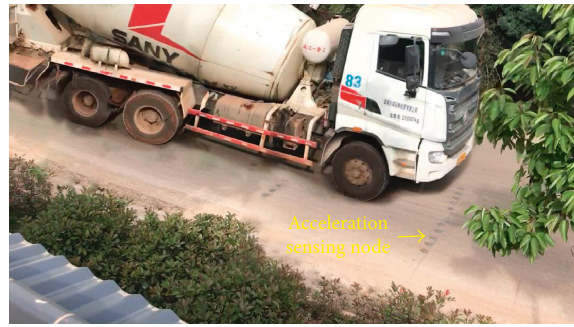
Figure 6: The field test on G320 road at Kunming.